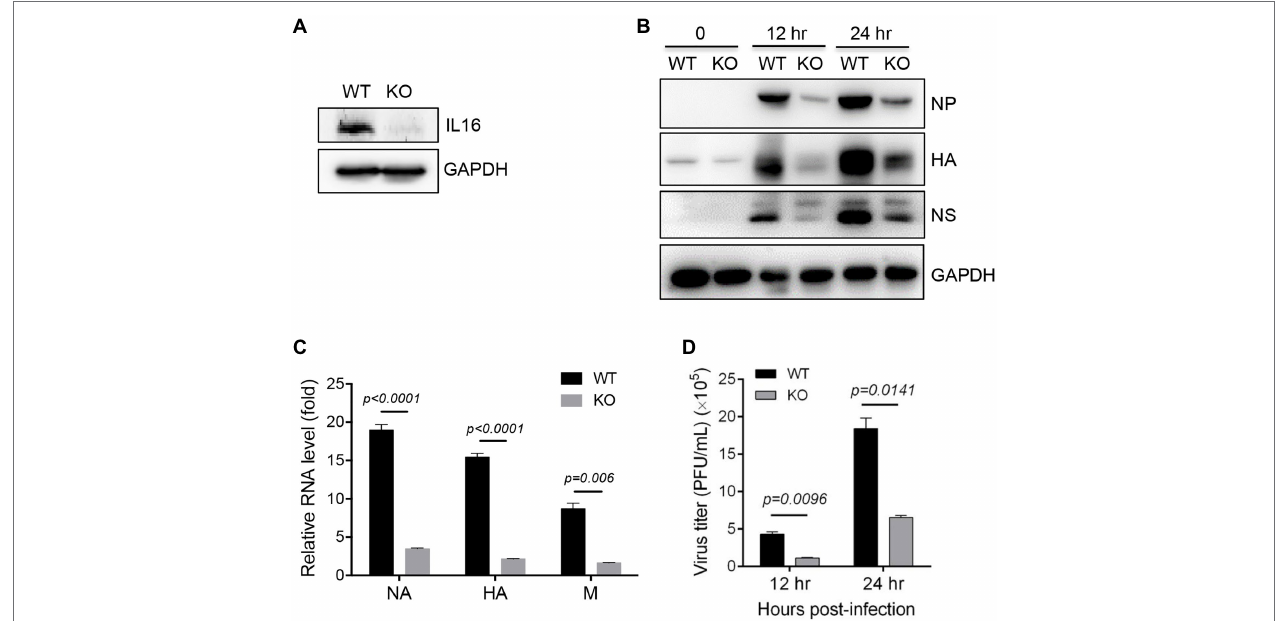
FIGURE 4 | IL16 deficiency inhibits IAV replication. (A) Detection of IL16 expression in WT and IL16 KO mouse embryonic fibroblasts (MEFs) using immunoblot analyses, GAPDH was used as a loading control. (B) WT and IL16 KO MEFs were infected with PR8 virus (MOI = 0.1) for 12 and 24 h. The protein levels of NP, HA, and NS were detected by immunoblot analyses with the indicated antibodies. (C) WT and IL16 KO MEFs were infected with PR8 virus (MOI = 0.1) for 24 h. The relative mRNA levels of NA, HA, and M genes were determined by qRT-PCR. Histograms represent mean ± SD of triplicate samples (two experiments). A value of p < 0.05 was considered significant. (D) WT and IL16 KO MEFs were infected with PR8 virus (MOI = 0.1) for 12 and 24 h. The supernatant was collected and subjected to plaque assay for measuring virus titer. Histograms represent mean ± SD of triplicate samples (three experiments). A value of p < 0.05 was considered